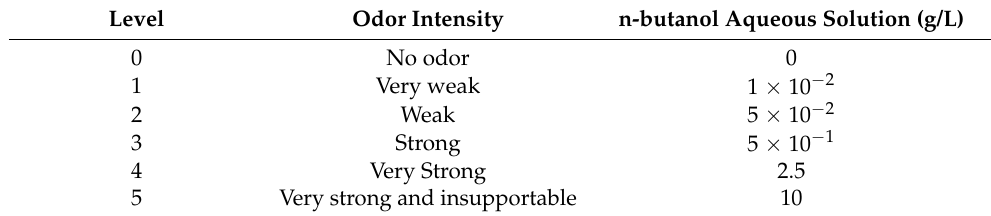
Table 2. n-butanol odor intensity referencing